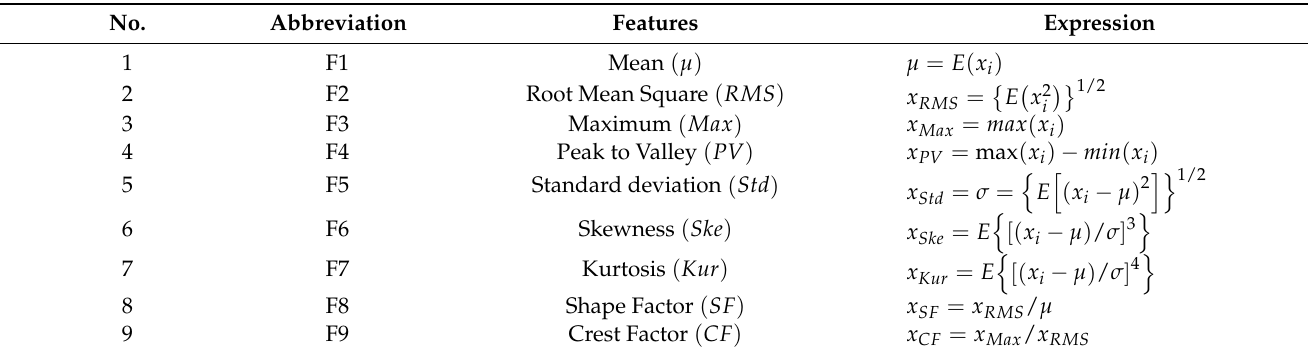
Table 1. The extracted time domain features.